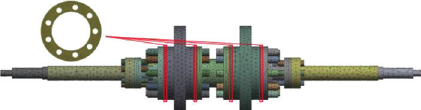
Figure 9: FE model with thin-layer element for model updating